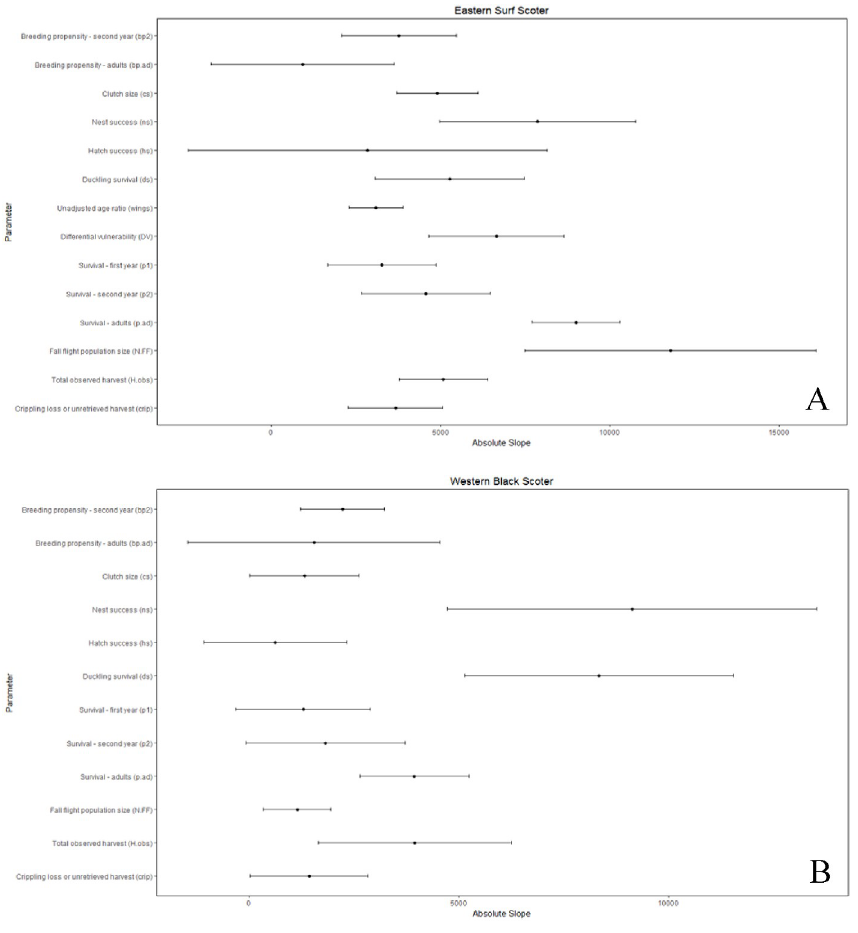
Fig 4. Sensitivity of the difference between allowable and observed harvest to individual demographic parameters as measuredby the slope of linear relationships between the harvest difference and standardized values of the demographic parameters, where greater absolute slope indicates higher sensitivity. Slope is affected by both the inherent sensitivity of growth rate and, hence, allowable harvest, to each parameter and its relative proportional uncertainty. Bars reflecting relative proportional uncertainty represent the coefficient of variation for non-binomial parameters or concentration for binomial parameters and, in both cases, have been multiplied by 100 (divided by 1000 for eiders) for scaling and presentation purposes. (A) eastern surf scoter, (B) western black scoter.